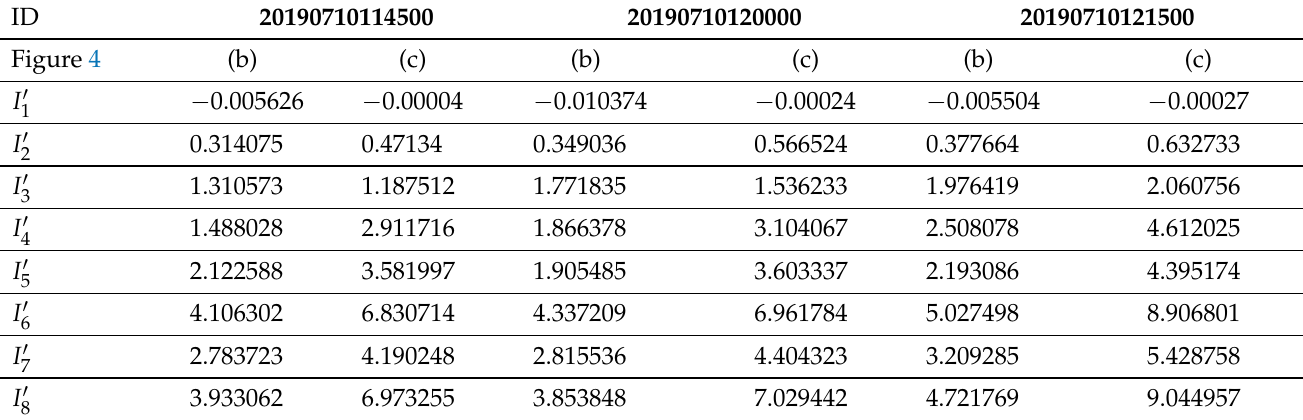
Table 2. Results the calculations of the invariants of the central moments according to Figure